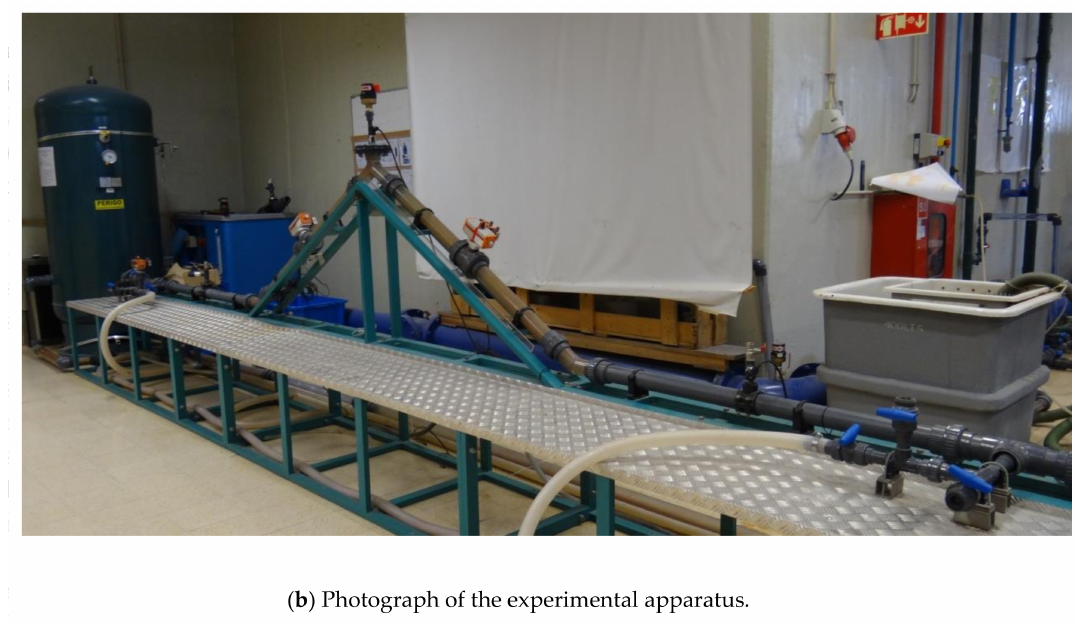
Figure 3. Schematic of filling process apparatus.